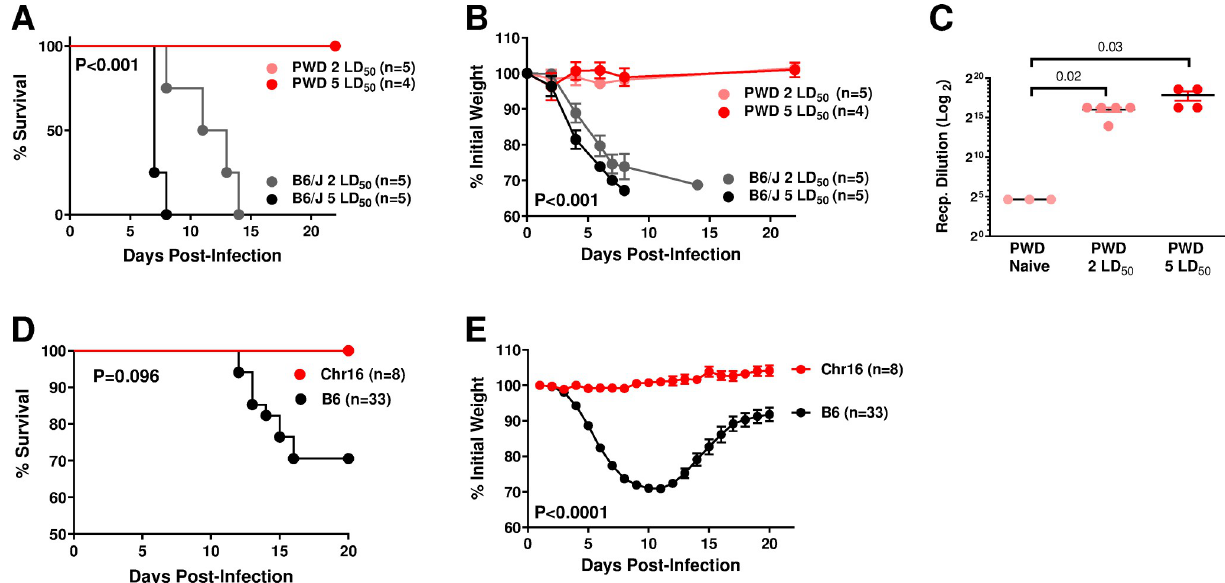
Fig 1. PWD alleles on Chr16 provide complete protection from lethal IAV challenge. ( A–C ) Male B6 and PWD mice were challenged with 2 LD 50 or 5 LD 50 doses of PR8 IAV (LD 50 dose was pre-determined on B6 mice). Survival ( A ) and weight loss ( B ) are shown, with P values in each panel indicating overall significance of differences between the groups, as determined by Mantel-Cox test and 2-way ANOVA, respectively. ( C ) On day 22 post-infection, serum was collected from PWD mice and uninfected na ï ve PWD mice, and anti-IAV antibody titers were determined by ELISA (as described in the Materials and Methods). P values indicate the significance of difference between the indicated groups, as determined by student’s T test. ( D, E ) Male and female B6 and B6.Chr16 PWD (Chr16) mice were challenged with ~LD 50 of PR8 IAV. Survival ( D ) and weight loss ( E ) are shown, representing pooled data from males and females with P values in each panel indicating significance of differences between the strains, as determined by Mantel-Cox test and 2-way ANOVA, respectively. The number of animals per condition is indicated in each